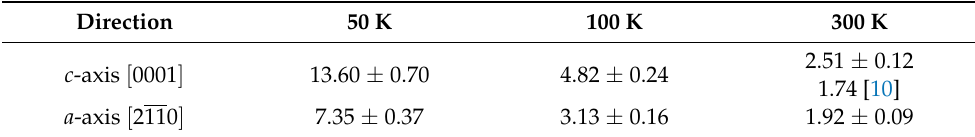
Figure 11. Temperature dependences of the thermal conductivity of the undoped CeF 3 and LaF 3 [65] crystals in different crystallographic directions ( a ) and the anisotropy coefficient K of the thermal conductivity of the CeF 3 single crystals ( b ). Table 4. The thermal conductivity values (W · m − 1 · K − 1 ) of an undoped CeF 3 single crystal at different